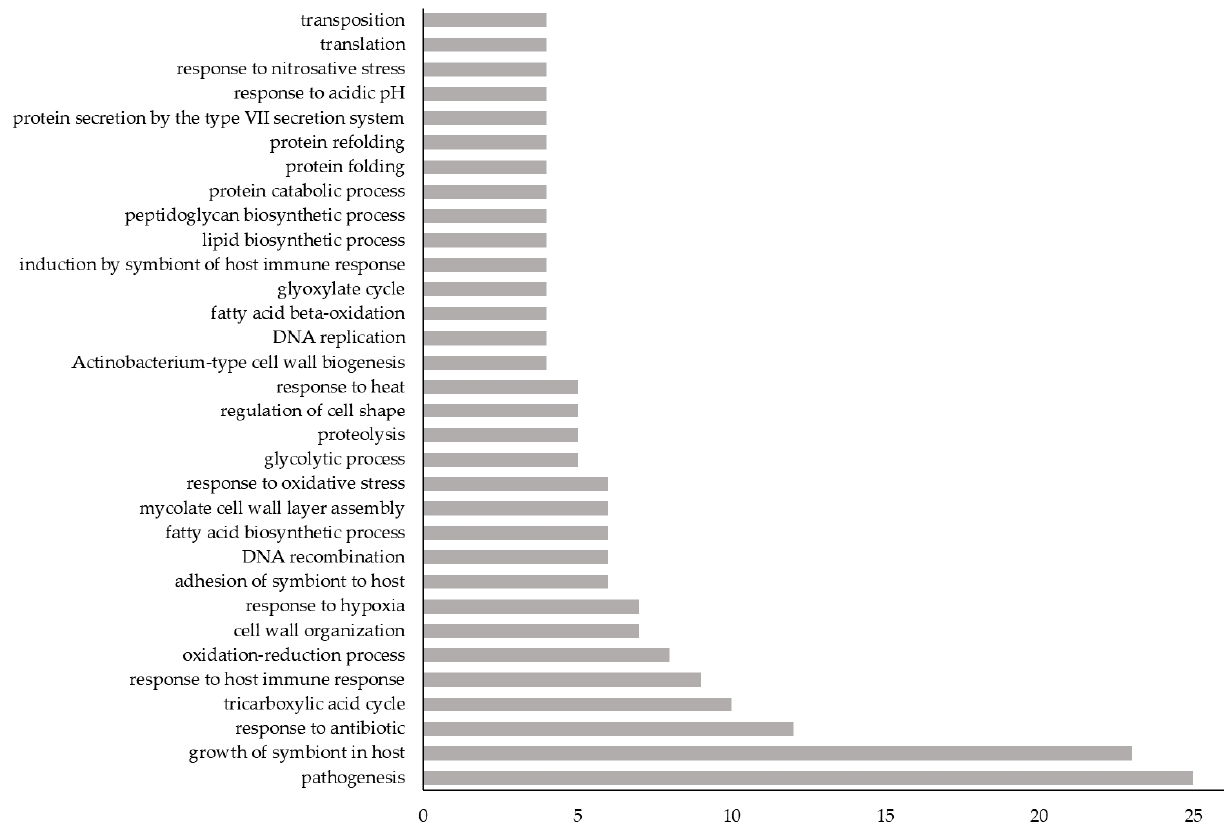
Figure 2. The frequency of GO biological processes among the 214 novel Vaxign-ML-predicted PAgs. X -axis: number of novel Vaxign-ML-predicted PAgs having the given GO biological process; Y -axis: GO biological processes to which at least 4 novel Vaxign-ML-predicted PAgs belonged. For a complete list of GO biological processes belonging to these 214 proteins, see Table S1.